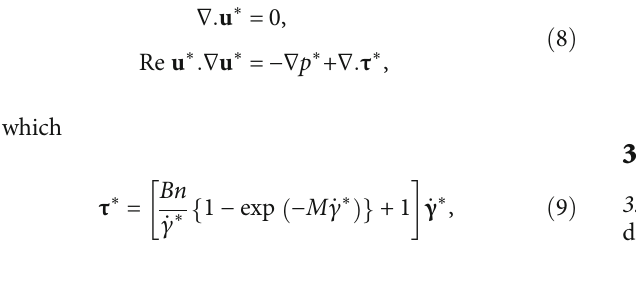
= 0 : 3 and Re = 20 . (a) Bn = 0 . (b) Bn = 10 . (c) Bn = 50 p